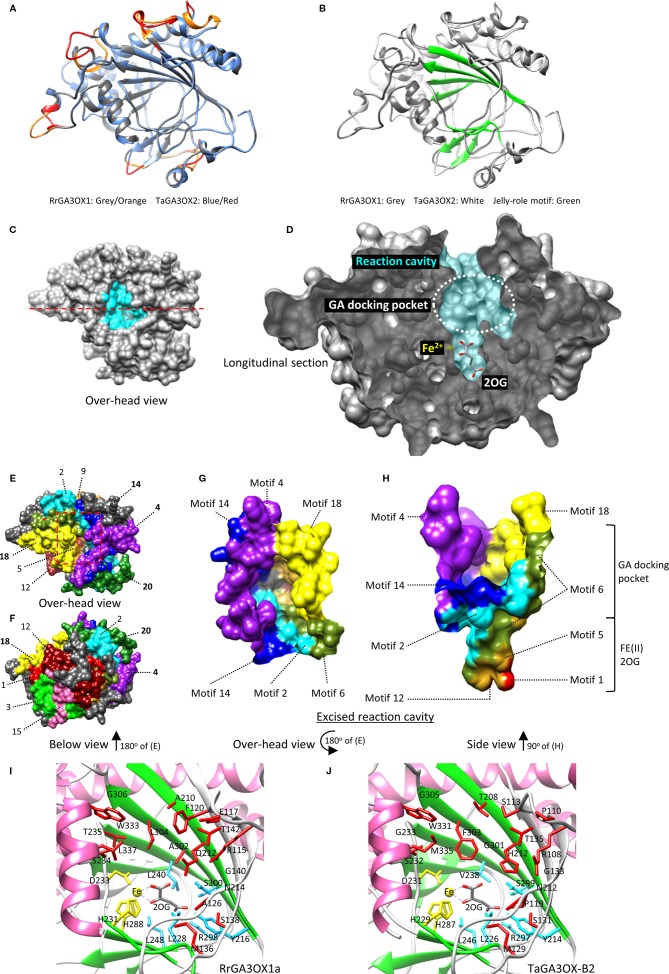
Modeling wild radish and wheat GA3OX proteins to identify functionally important regions and potential substrate contact residues. (A) Tertiary protein structure of RrGA3OX1 superimposed over TaGA3OX1. The two proteins have very similar modeled structures with regions of high similarity depicted in grey/blue. Regions with greater structural differences between the two proteins are colored red/orange (“Low. Mod. Qual.” in Figure 7). (B) Superimposed tertiary structures of RrGA3OX1 and TaGA3OX1 proteins highlighting the well modeled jelly-roll motif which constitutes the reaction cavity. (C, D) Surface mapping of the RrGA3OX1a tertiary protein structure reveals the reaction cavity; similar for all RrGA3OX and TaGA3OX proteins. (C) Over-head vantage providing a view into the reaction cavity (highlighted cyan). (D) Longitudinal section along the red dashed line in (C), revealing the profile of the reaction cavity. In the depths of the reaction cavity residue the FE(II) ion and 2OG co-substrate. Superior to these molecules is the GA docking pocket. (E, H) Mapping MEME motifs onto the RrGA3OX tertiary structure. (E) Similar overhead vantage view as in (C), but with the residues color coded according to their residing motif. Color coding and number labels match those of the MEME output in Figure 6C. (F) Below view (180° rotation of (E) pivoting on the x-axis) providing another perspective and revealing the other motifs. (G, H) A dissection of the tertiary structure showing the excised reaction cavity and the motif sequences that comprise it. (G) Over-head view looking down into the reaction cavity. (H) Side view of the intact reaction cavity showing the contribution of the different motifs to both the GA docking pocket and the deeper FE(II) and 2OG docking pocket. The GA docking pocket is made up of motifs 2, 4, 6, 14, and 18. The depths of the cavity where the FE(II) and 2OG reside are made up of motifs 1, 2, 5, 6, and 12. (I, J) Close-up of the reaction cavity of both RrGA3OX1a and TaGA3OX1-2, showing the amino acids lining the cavity with reactive sidechains orientated inwards toward the reactive center. The position of the FE(II) ion is coordinated by side chains of yellow colored residue, while the position of the 2OG co-substrate is co-ordinated by the cyan colored residues. The 12 putative GA contact residues, surrounding the GA docking pocket (black dashed circle), are colored red.